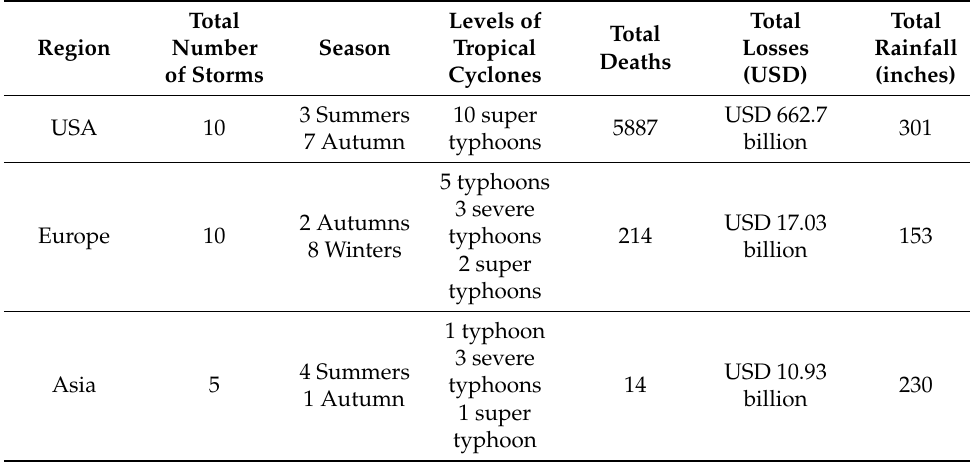
Table 7. Summary of tropical cyclones in the USA, Europe, and Asia since